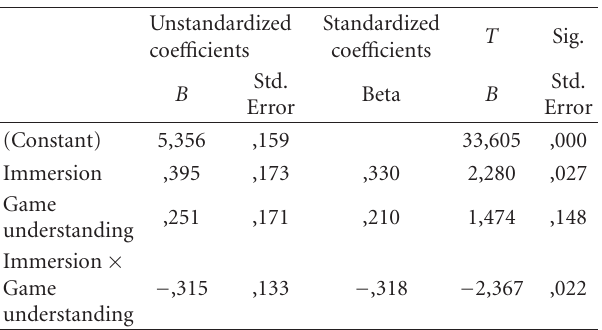
Table 9: Regression results.